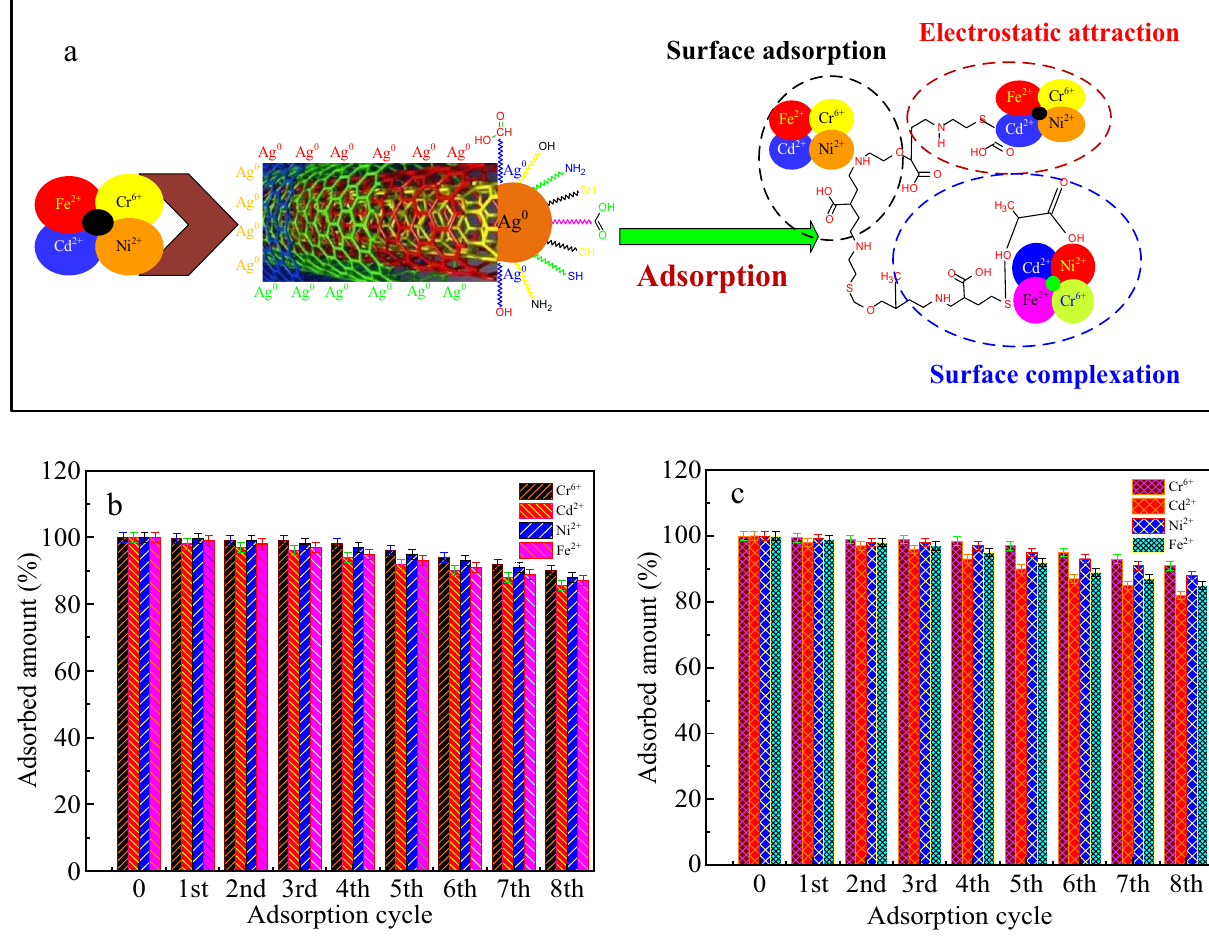
Figure 4. (a) possible adsorption mechanism of Cr(VI), Ni(II), Fe(II) and Cd(II) ions adsorption by MWCNTs-KIAgNPs; Reusability of MWCNTs-KIAgNPs towards Cr(VI), Ni(II), Fe(II) and Cd(II) ions adsorption in (b) batch system (MWCNTs-KIAgNPs dosage: 40 mg, pH 3 for Cr(VI) and 6 for Ni(II), Fe(II) and Cd(II) ions and contact time = 60 min) and (c) continuous system (bed depth = 6 cm, flow rate = 5 mL/min, influent concentration = Cr(VI) (21.25 mg/L), Ni(II) (16.50 mg/L), Fe(II) (14.00 mg/L) and Cd(II) (11.00